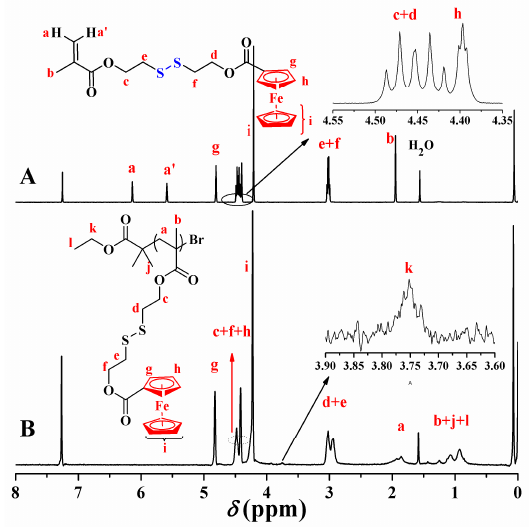
Figure 1. 1 H-NMR spectra of FcMAss monomer and PFcMAss homopolymer.